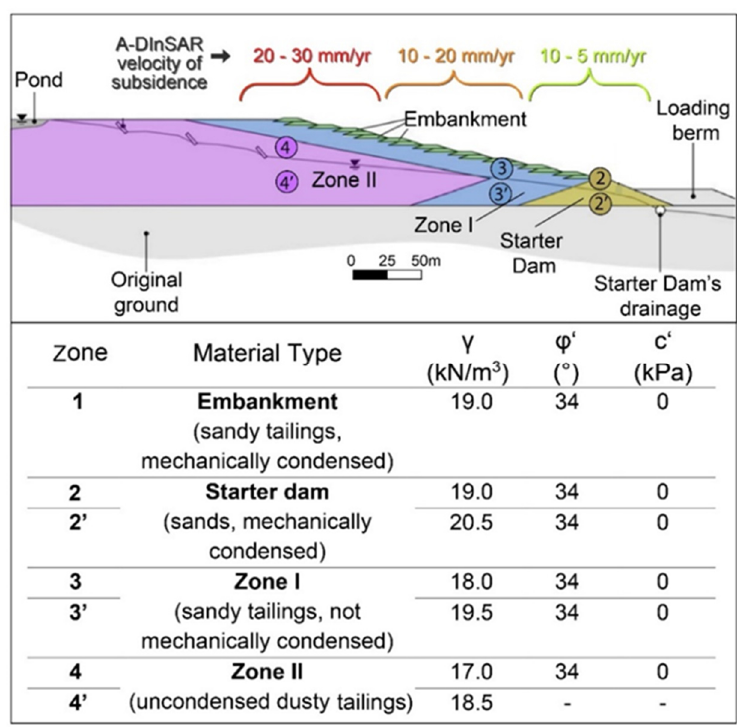
Figure 8. Scheme of tailings zoning in the site’s embankment and selected geotechnical parameters of the soil form [30]; 2’, 3’ and 4’ are for fully saturated material; γ : unit weight; φ ’: internal friction angle; c’: effective cohesion; AD-InSAR subsidence velocities measured in this work are also reported above the profile.